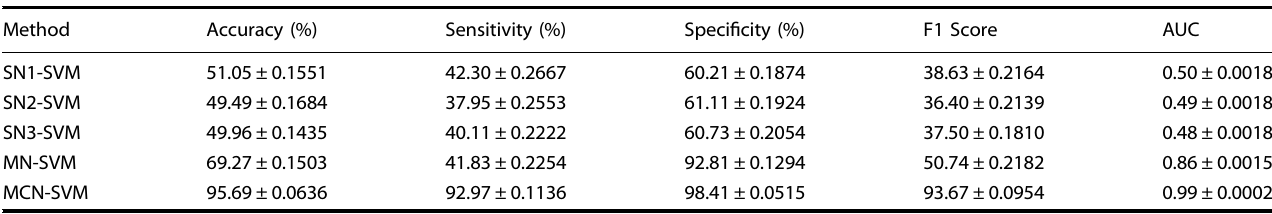
Table 1. Comparison of different methods for early PD vs. HC classi fi